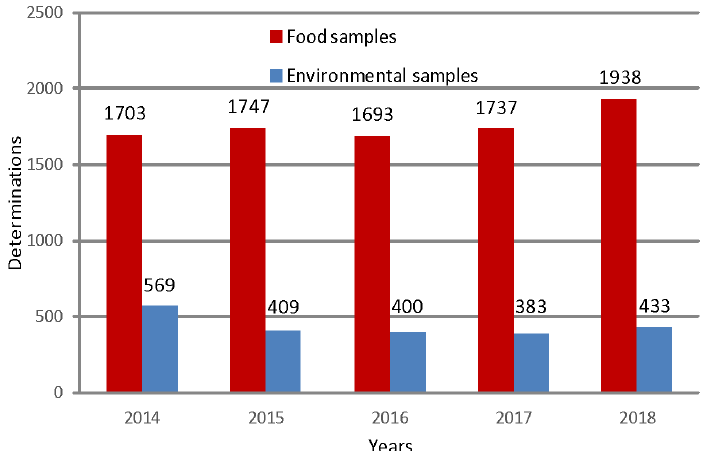
Figure 1. Number of analytical determinations performed for food and environmental samples per year.